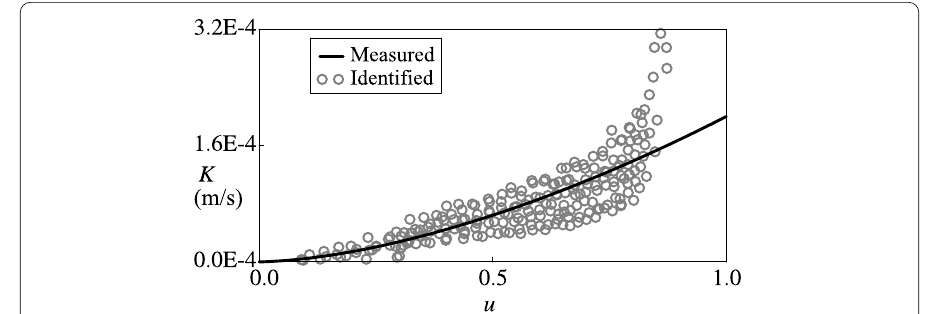
Figure 8 Comparison of measured and identified hydraulic permeability K ( u ).